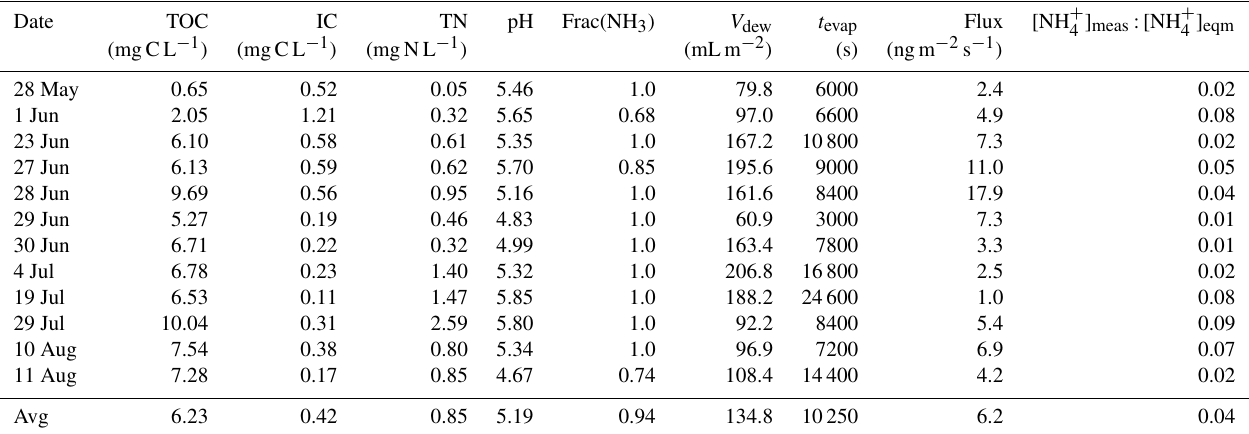
Table 1. Total organic carbon (TOC), total nitrogen (TN), inorganic carbon (IC), pH, the ratio of measured to predicted [NH + parameters pertinent to NH 3 flux calculations in the field dew